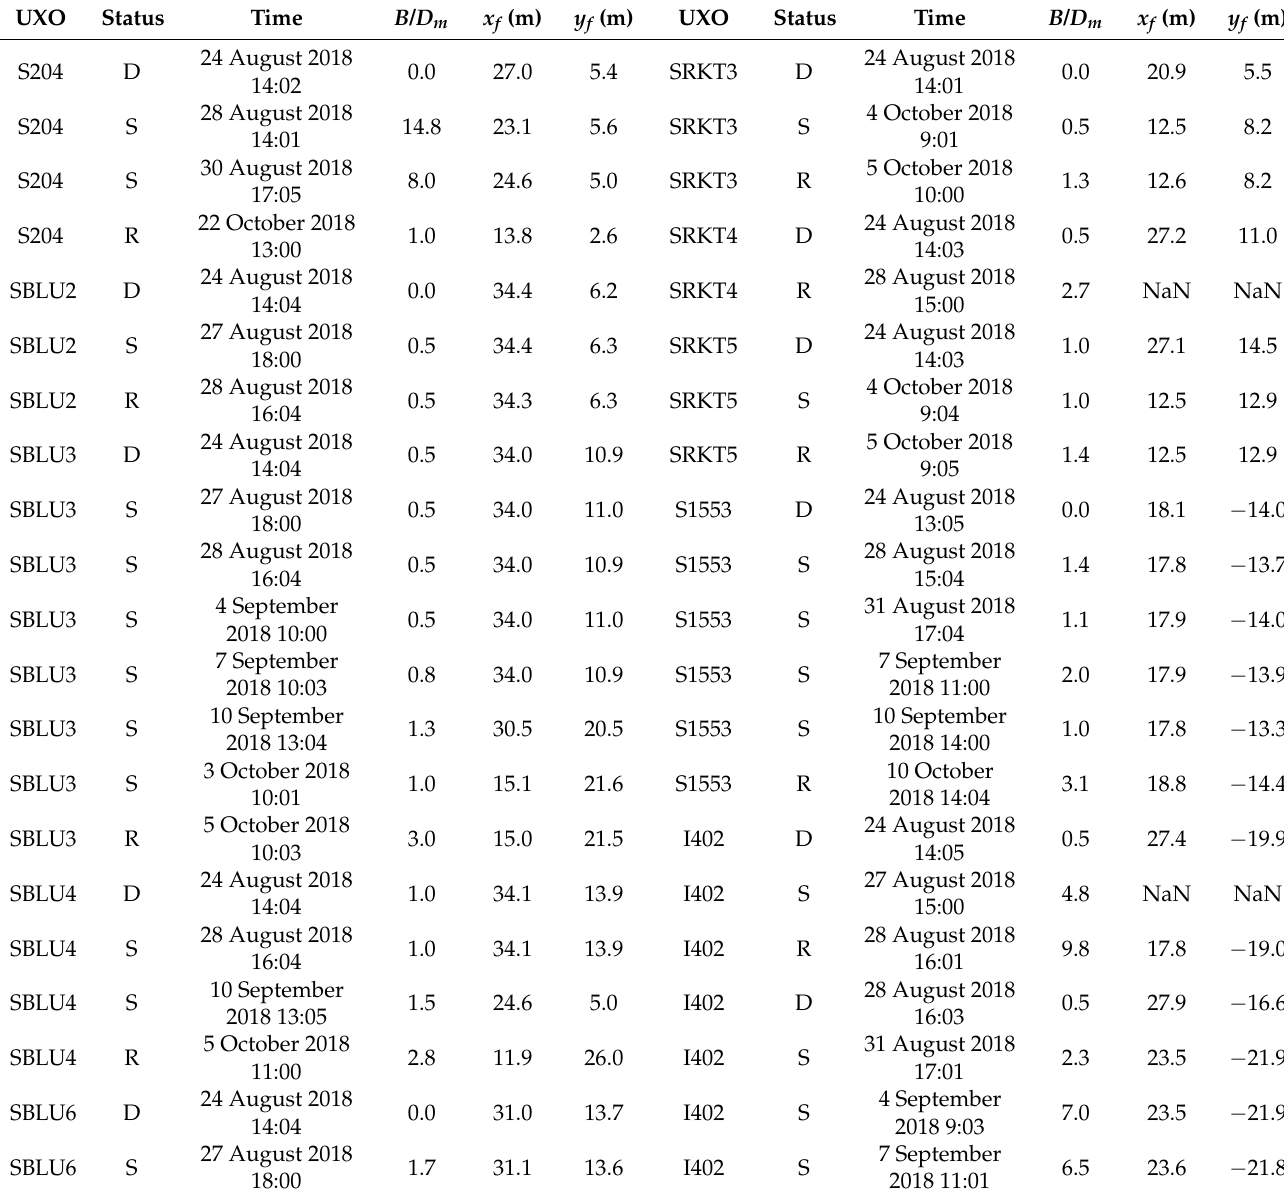
Table A1. Surveys of of x f , y f position and burial relative to local bed level for long term deployed munitions that were retrieved before the end of the experiment. The character ‘S’ and ‘I’ at the beginning of each UXO id highlight the difference between a Surrogate and an Inert. The acronyms ‘D’, ‘S’ and ‘R’ in the status column stand for Deployed, Surveyed,